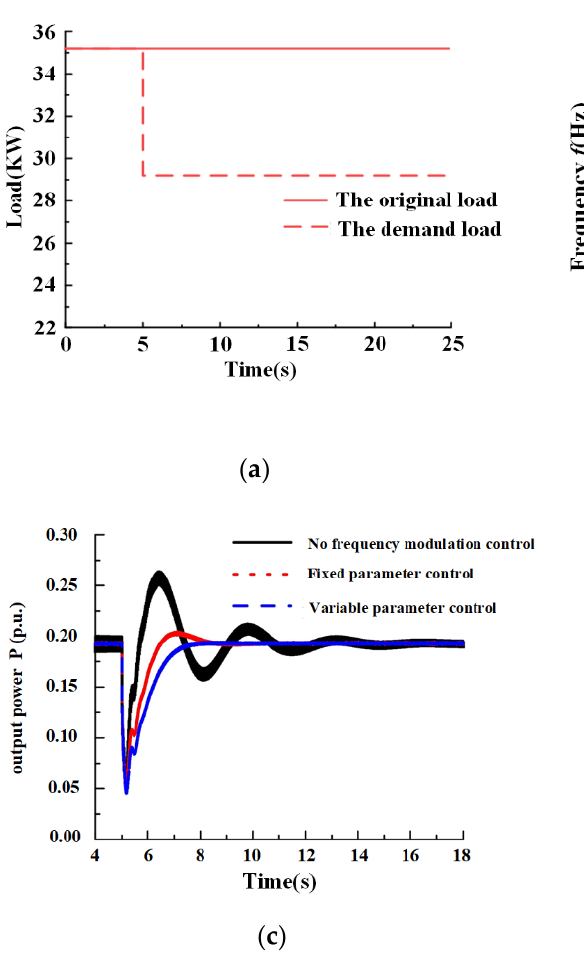
Figure 18. Comparison simulation curve of frequency modulation control with a load decrease of 6 kW. ( a ) The demand load curve. ( b ) System frequency response curve. ( c ) Wind-driven generator output active power response curve. ( d ) Conventional generator output active power response curve.